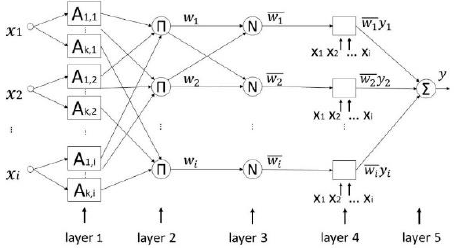
Figure 1. The TSK ANFIS architecture [107].